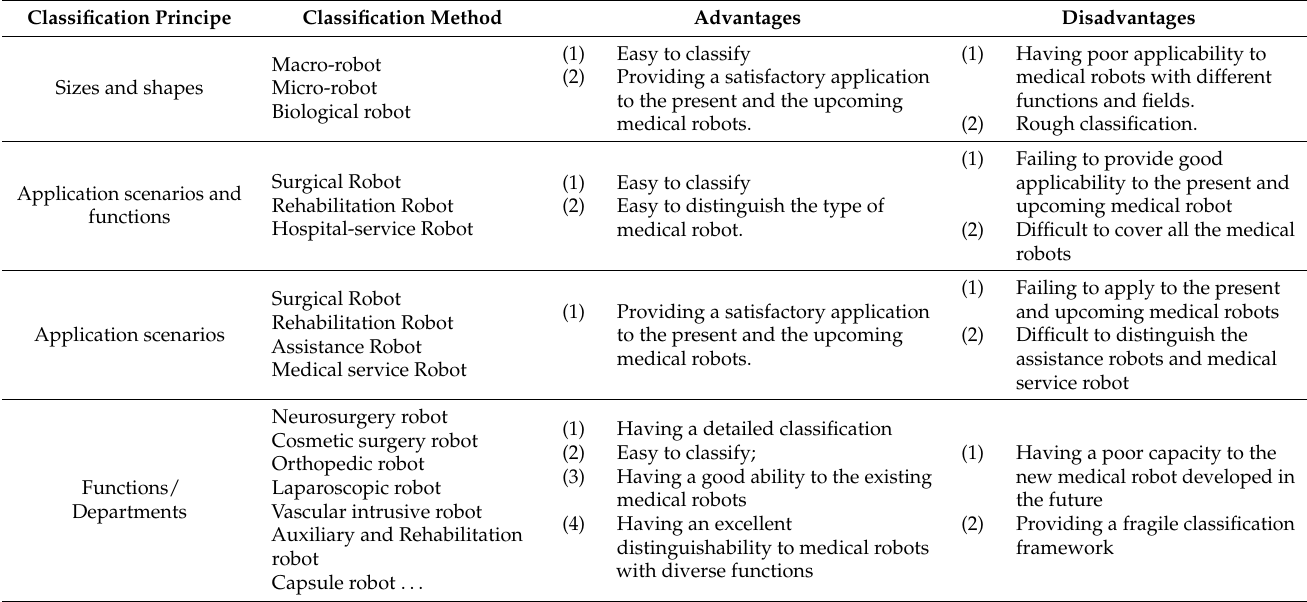
Table 1. Classification methods proposed for medical